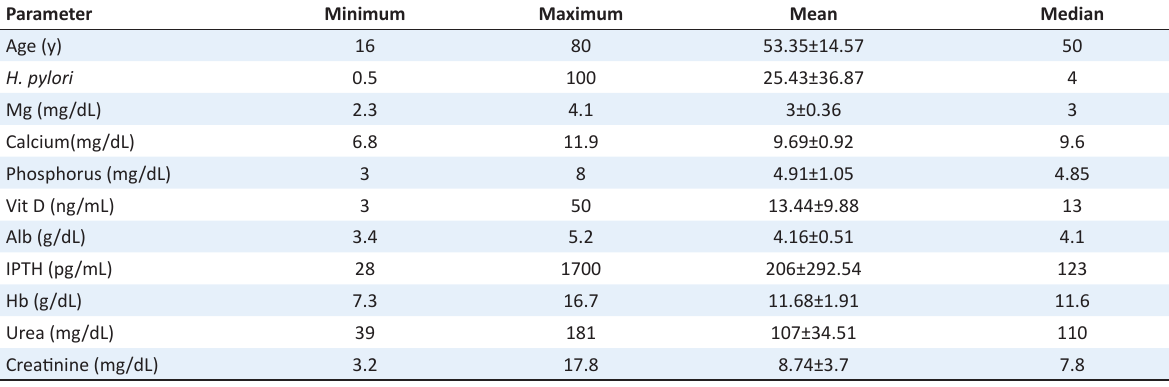
Table 1. Demographic and biochemical data of patients